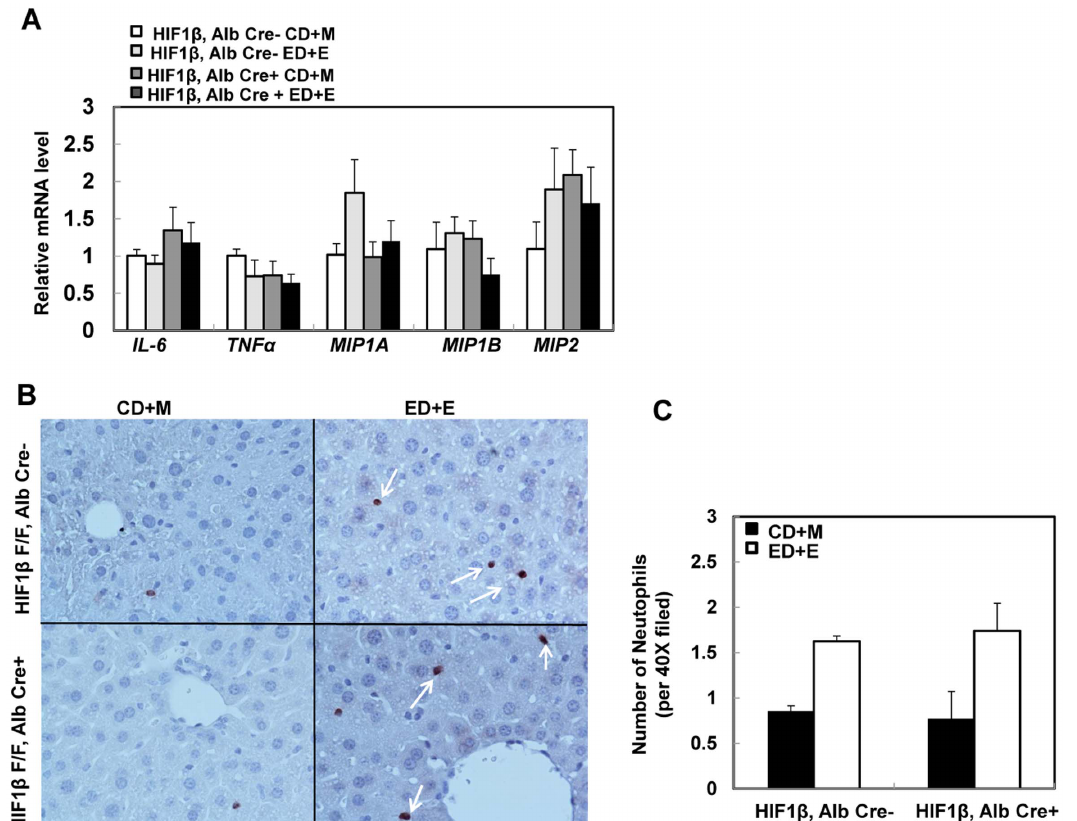
Fig. 6. Changes in markers of hepatic inflammation in wild type and hepatocyte-specific HIF-1 b knockout mice after Gao-binge treatment. Age matched male wild type and hepatocyte-specific HIF-1 b knockout mice were subjected to Gao-binge treatment. Hepatic mRNA was isolated, and real-time RT-PCR was performed as described in the Materials and Methods (A). Data are presented as means ¡ SE (n 5 3–5). Liver tissue was subjected to immunostaining for neutrophils using an anti-Ly6B antibody and representative images are shown in (B, 40x), and the number of neutrophils were quantified from 10 different fields of each mouse. (C). Data are presented as average number of neutrophils in each filed (means ¡ SE; n 5 4).